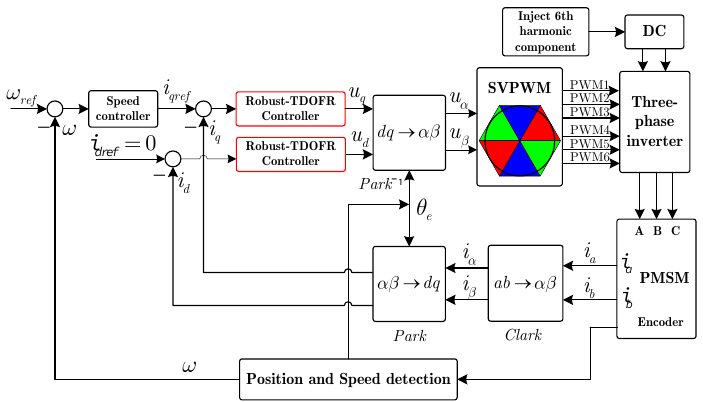
Figure 7. Structure diagram of the proposed Robust-TDOFR controller.